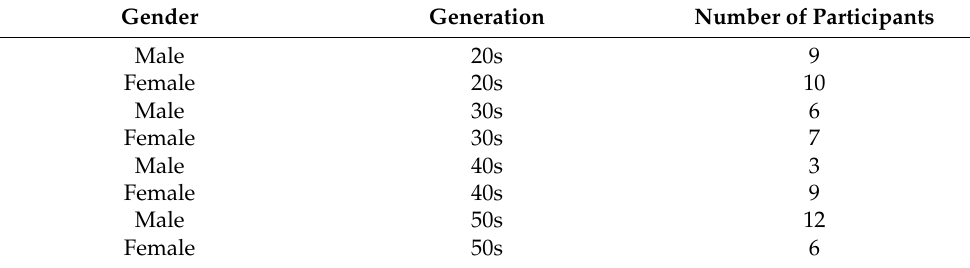
Table 2. Number of participants divided by gender and generation.